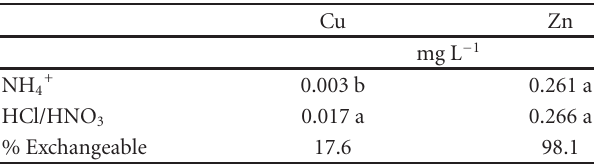
Table 4: Colloid bound metals extracted by ammonium acetate (NH 4+ ) and 1M acid in mg L − 1 in selected samples, with letters representing di ff erences at 0.01 between the extraction